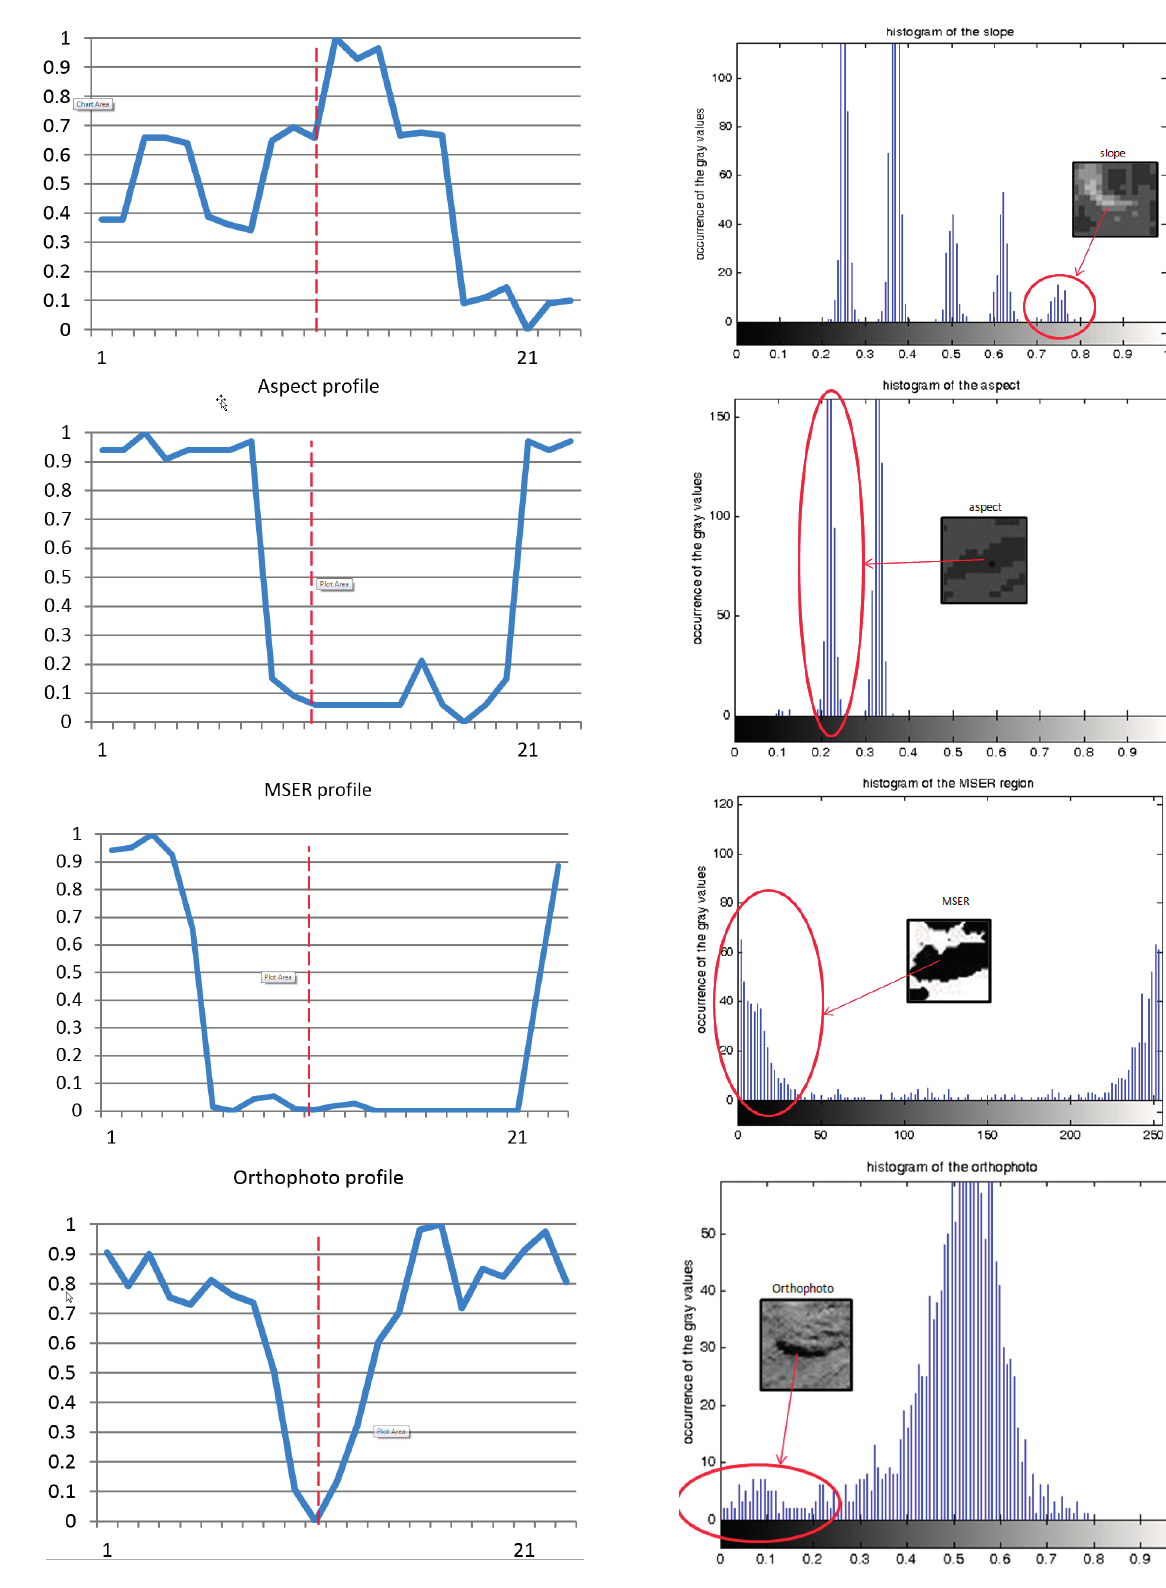
Figure 9. Showing the profiles that intersected the fractures around the landslide